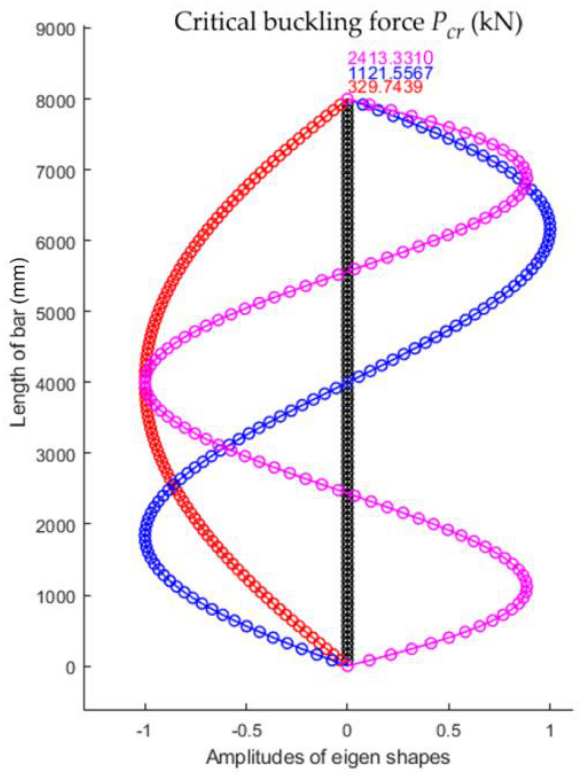
Figure 18. The first three shapes of stability loss and corresponding critical buckling forces for the bar with parabolic variation in the second moment of inertia along the bar axis.